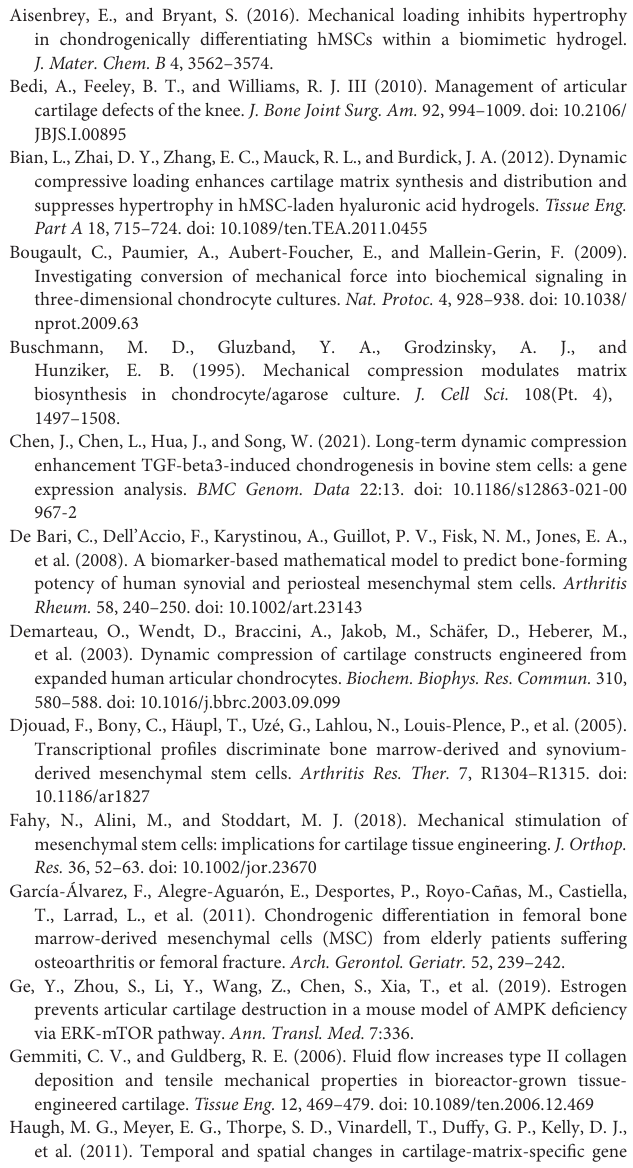
development of SMSCs. Gene expression of chondrogenesis and hypertrophy development. Results are presented as the mean ± S.D. * P < 0.05, ** P < 0.01, *** p < 0.001. COL2 α 1, collagen type II; SOX9, SRY-box transcription factor 9; COL1 α 1, collagen type I; COL10 α 1, collagen type X; RUNX2, RUNX family transcription factor 2; MMP13, metalloproteinases 13; ALP, alkaline phosphatase. Supplementary Figure 4 | Gene expression of chondrogenesis and hypertrophy development after retraction of TGF- β 3. The SMSC constructs were allowed to undergo chondrogenic differentiation until day 21. Subsequently, TGF- β 3 was withdrawn in half of the constructs, and the constructs subjected to compression or control were further divided into TGF- β 3-continued group and TGF- β 3-discontinued group. Results are presented as the mean ± S.D. * P < 0.05, ** P < 0.01, *** p < 0.001. COL2 α 1, collagen type II; SOX9, SRY-box transcription factor 9; COL10 α 1, collagen type X; RUNX2, RUNX